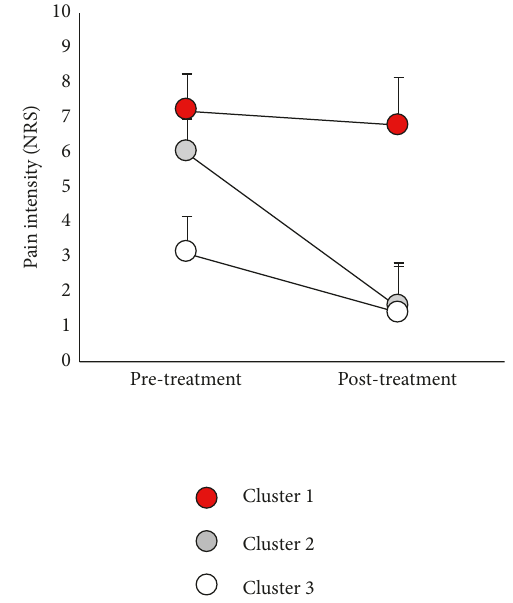
Figure 2: Types of pain reduction of each cluster. Data are pre- sented as mean SD ( n 101). NRS, numerical rating scale. (cid:31) ± Table 2: Radiographic assessment of each cluster.